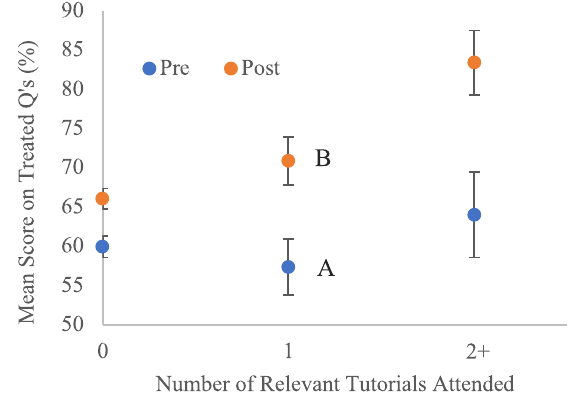
FIG. 2. Mean student pretest and post-test scores on the set of all continuum-scored GQMA items for which they attended N relevant GGW sessions, for N ¼ 0 , 1, 2 or more. Error bars represent standard error. The numbers of student items in the three treatment categories are 607, 107, and 37, respectively, and these originate from 133 students ’ work.